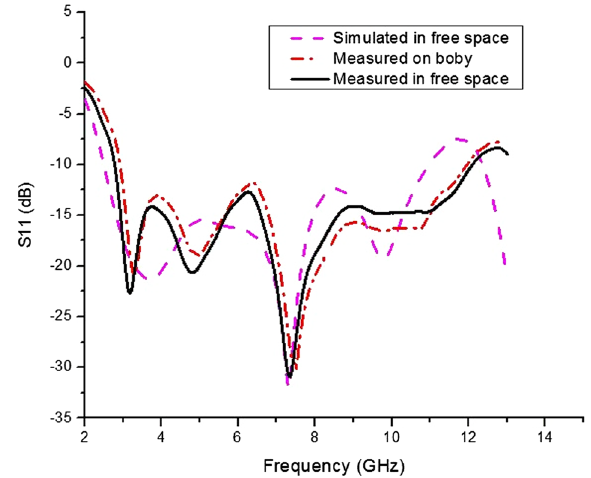
Fig. 4 Comparison of simulated S 11 with measured S 11 on the body and free